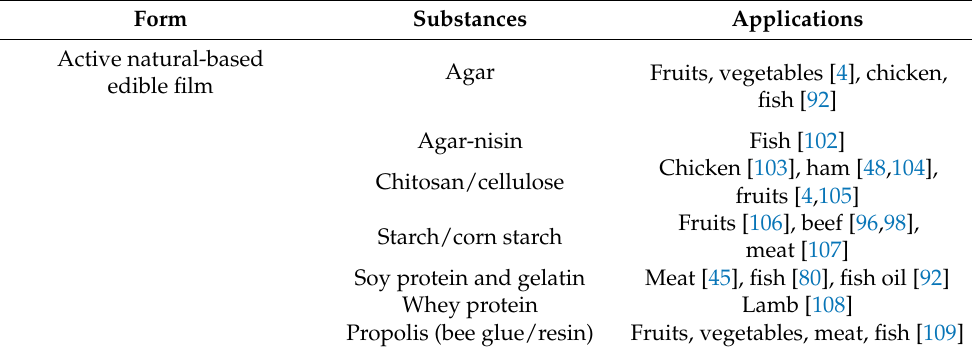
Table 3. Natural materials for food packaging. Form Substances Applications Active natural-based Agar Fruits, vegetables [4], chicken, edible film fish [92] Agar-nisin Fish [102] Chicken [103], ham [48,104], Chitosan/cellulose fruits [4,105] Fruits [106], beef [96,98], Starch/corn starch meat [107] Soy protein and gelatin Whey protein Lamb [108] Propolis (bee glue/resin) Fruits, vegetables, meat, fish